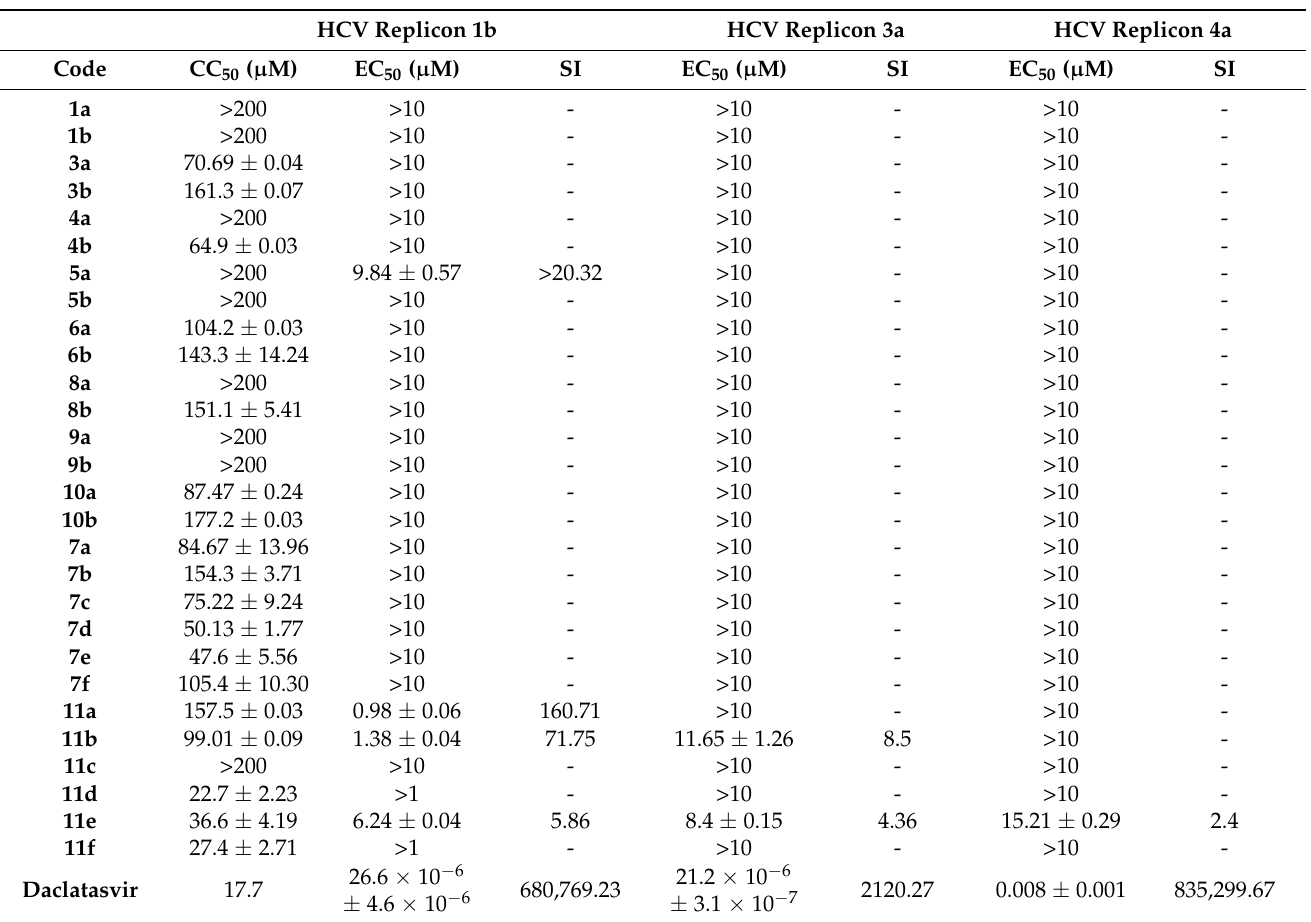
Table 2. EC 50 , CC 50 , and SI values of compounds in HCV replicon cell lines of GT 1b (Con1), GT 3a (S52), and GT 4a